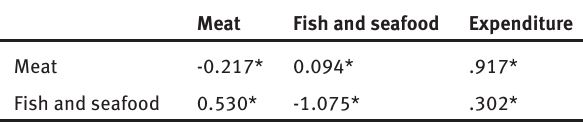
Fish and seafood